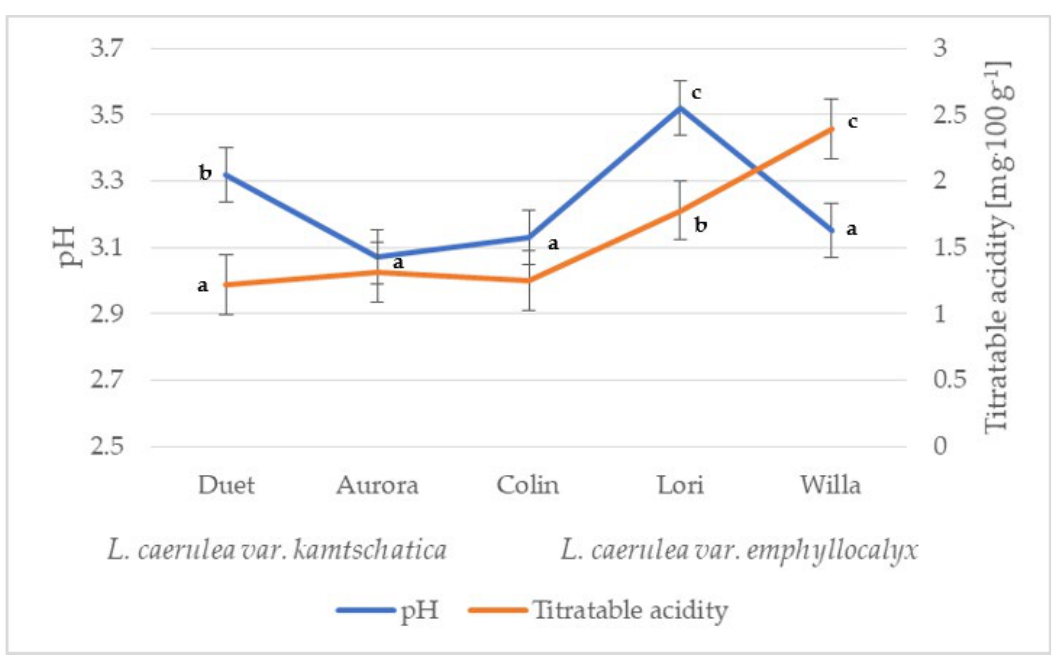
Figure 1. pH and total acidity of L. caerulea var. kamtschatica and L. caerulea var. emphyllocalyx fruits (data are expressed as mean values ( n = 3) ± SD; SD—standard deviation). Mean values with different letters are significantly different ( p < 0.05).